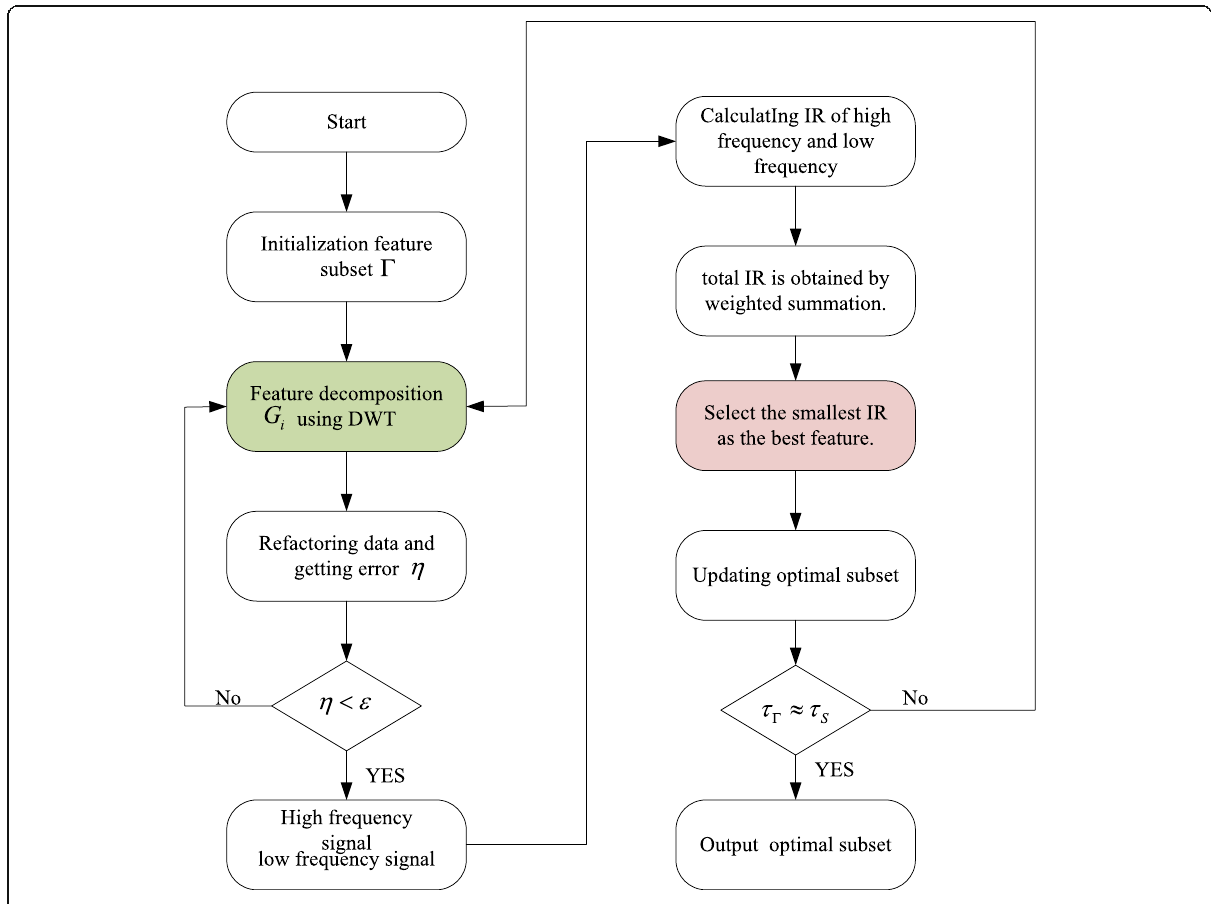
Fig. 3 The algorithm process of DWT-IR for feature